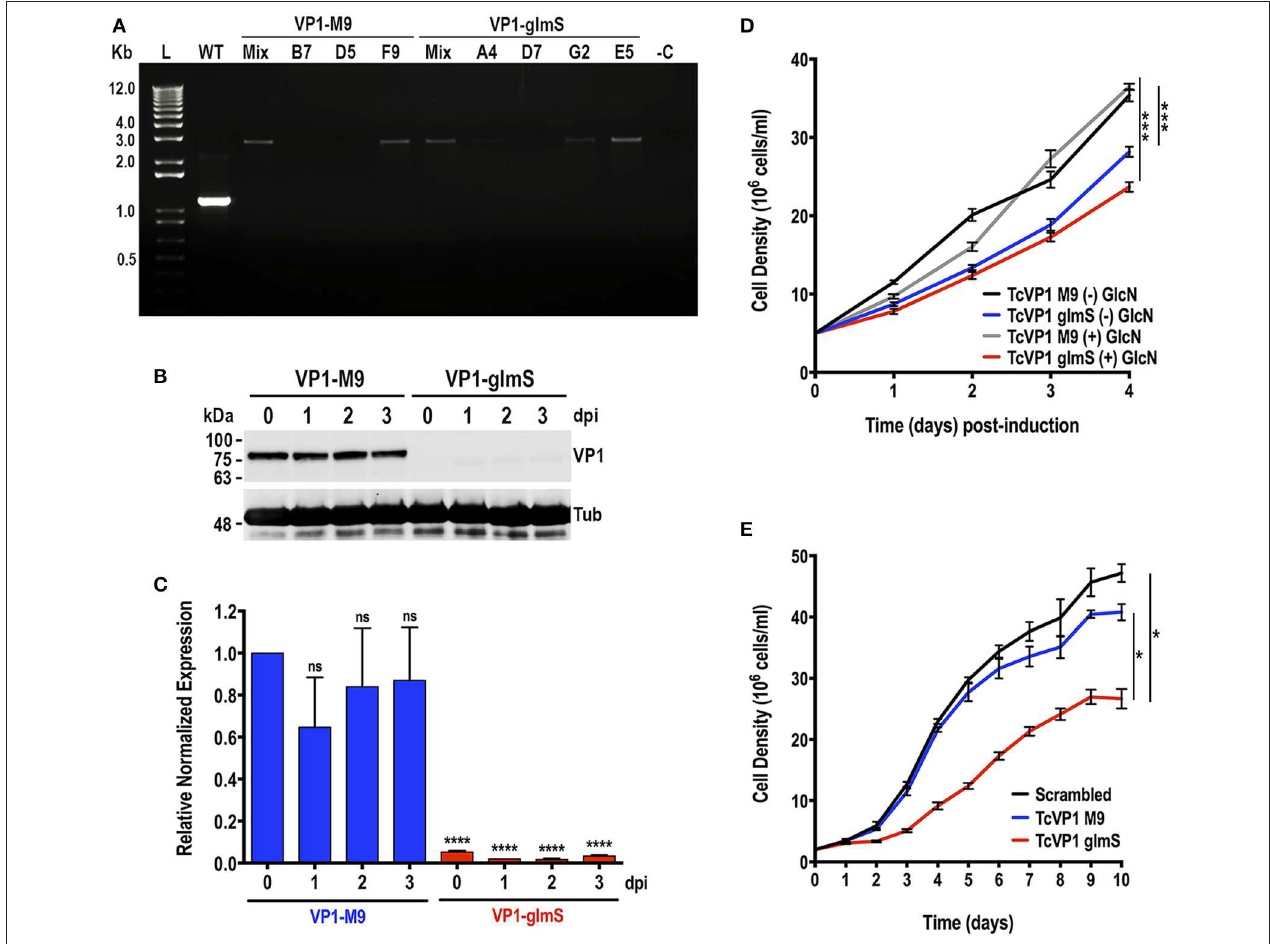
FIGURE 4 | Integration of glmS/M9 ribozyme sequences into the TcVP1 gene. (A) PCR analysis using gDNA isolated from WT and TcVP1-M9/glmS mixed (Mix) and clonal populations ( TcVP1-M9 , clones B7, D5, and F9; TcVP1-glmS , clones D7, G2, and E5). The primer set used ( Table S1 , primers 11 and 12) generates a band of 1,144 bp in wild type parasites (WT) and a band of 2,758 bp in TcVP1 -tagged ( M9 or glmS ) epimastigotes. Transfectant mixed and clonal populations were analyzed from both tagged versions of TcVP1 , and in both cases the band of 2,758 bp was detected in the originally transfected cell lines (Mix) and in some of the clones. Clones F9 ( TcVP1-M9 ) and E5 ( TcVP1-glmS ) were chosen for further phenotypic analysis. (B) Western-blot analysis of TcVP1-M9 and TcVP1-glmS cell lines. Anti TcVP1 monoclonal antibody labels a band of 85 kDa in TcVP1-3xHA - M9 - but not in TcVP1-3xHA - glmS - epimastigotes. Expression of TcVP1 was monitored during 3 days after addition of 10mM glucosamine to the medium (days post induction, dpi). Anti-tubulin antibody (Tub) was used as loading control. Antibodies are indicated on the right side of the blots, and molecular weights (kDa) are on the left side. (C) qRT-PCR analysis of TcVP1-M9 and TcVP1-glmS cell lines from 0 to 3 days post induction (dpi). (D) Growth in vitro of TcVP1-M9 and TcVP1-glmS epimastigotes cultured with [( + ) GlcN] or without [(–) GlcN] 10mM glucosamine. (E) Growth in vitro of scrambled, TcVP1-M9 and TcVP1-glmS epimastigotes cultured in LIT medium until reaching the stationary phase, without addition of glucosamine. In (C)